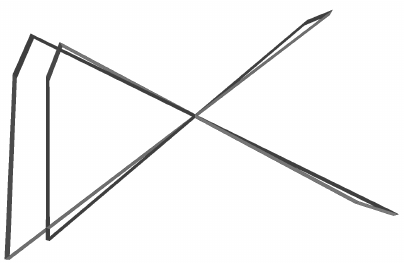
Figure 7. A prismatic polyhedron with an obvious self- intersection. The self-intersecting top and bottom faces of the polyhedron are not shown.